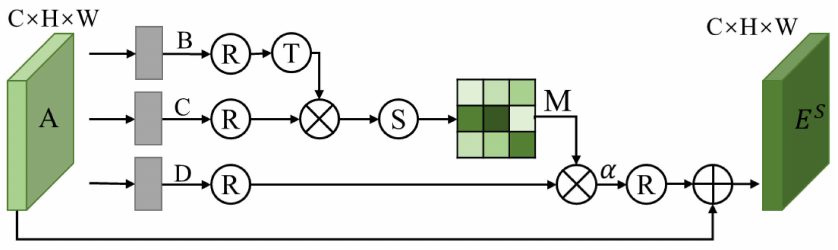
Figure 6. Spatial attention